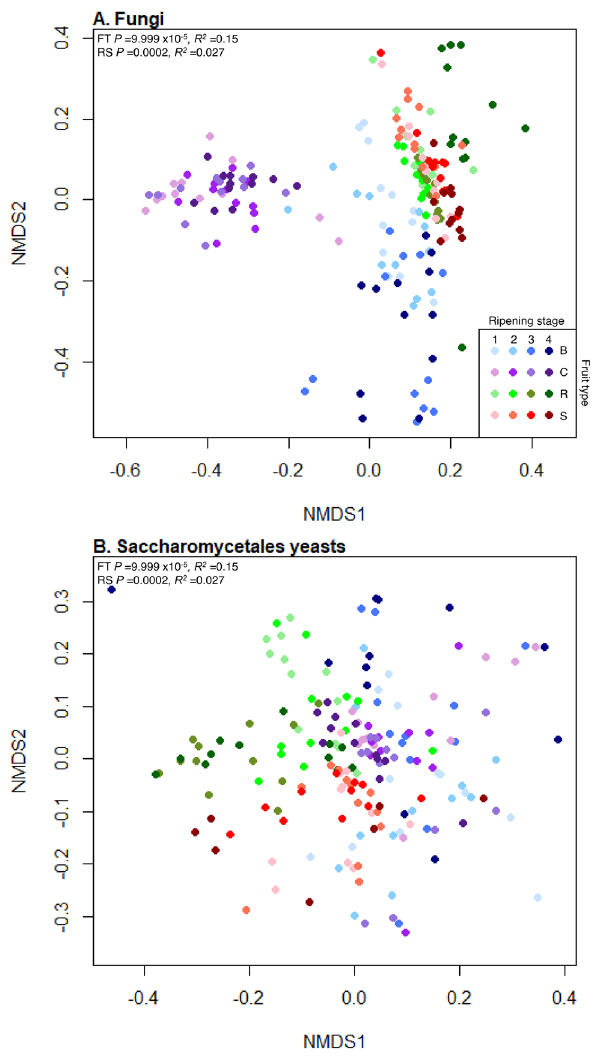
Figure 4. NMDS plots representing the differential abundances of fungal phylotypes. Nonmetric Multidimensional Scaling (NMDS) plots of abundance Jaccard measures of community dissimilarity of ( A ) total fungal communities and ( B ) Saccharomycetales budding yeasts on blueberry (blue), cherry (purple), raspberry (green) and strawberry (red) at four ripening stages (1, unripe/green fruit; 2, de-greening fruit; 3, ripening fruit; and 4, fully ripe/harvest fruit; denoted by shade of colour, lightest shade for green fruit and moving through to darkest shade for fully ripe/harvest). Both total fungal and Saccharomycetales yeasts communities significantly differ in the presences of phylotypes across all fruit types (FT) and ripening stages (RS) by PermANOVA (values shown top